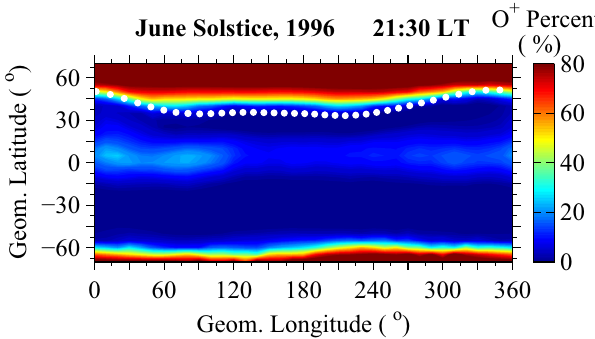
Fig. 6. Geomagnetic longitude and latitude variations of O + percent measured by the DMSP F12 at nightside 21:30 LT around the June Solstice of 1996. The white dotted line denotes the solar terminator at 300 km height at 21:30 LT.